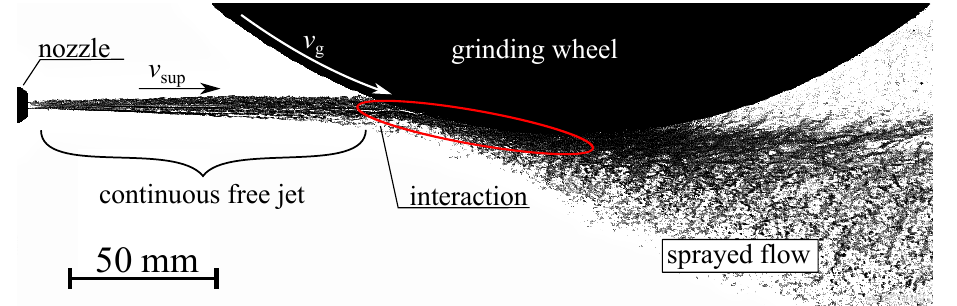
Figure 1. Edited shadowgram image of the MWF flow hitting a rotating grinding wheel without workpiece. The liquid gets projected as a continuous free jet onto the grinding wheel until the liquid-surface interaction divides the liquid into